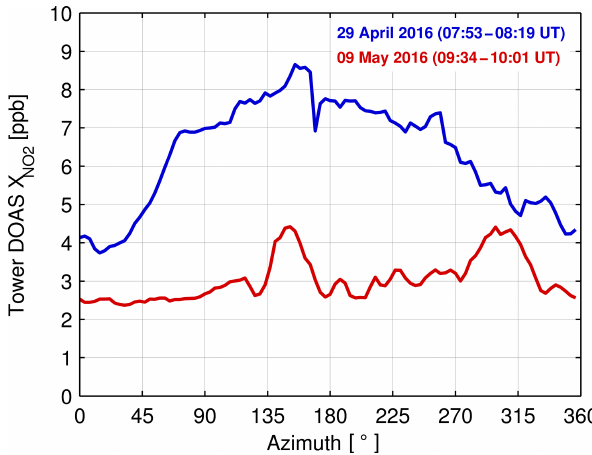
Figure 17. Comparison of lap-averaged near-surface NO 2 mix- ing ratios estimated from car DOAS zenith-sky measurements with NO 2 mixing ratios obtained from in situ measurements. Lap aver- ages of all 20 performed car rides are included in the calculation. The black and grey dotted lines represent the 1 : 1 relationship and ± 25%, respectively.